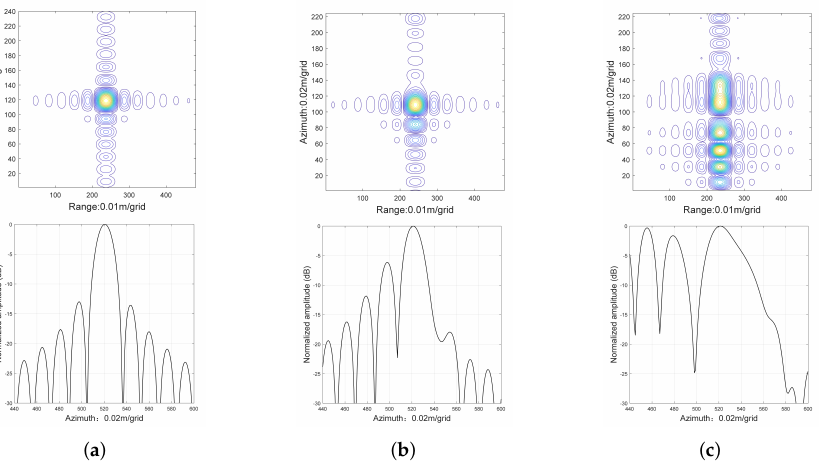
Figure 20. Two-dimensional point spread functions and the corresponding azimuth profiles of ( a ) Point 8, ( b ) Point 9 and ( c ) Point 10 in Figure 19,